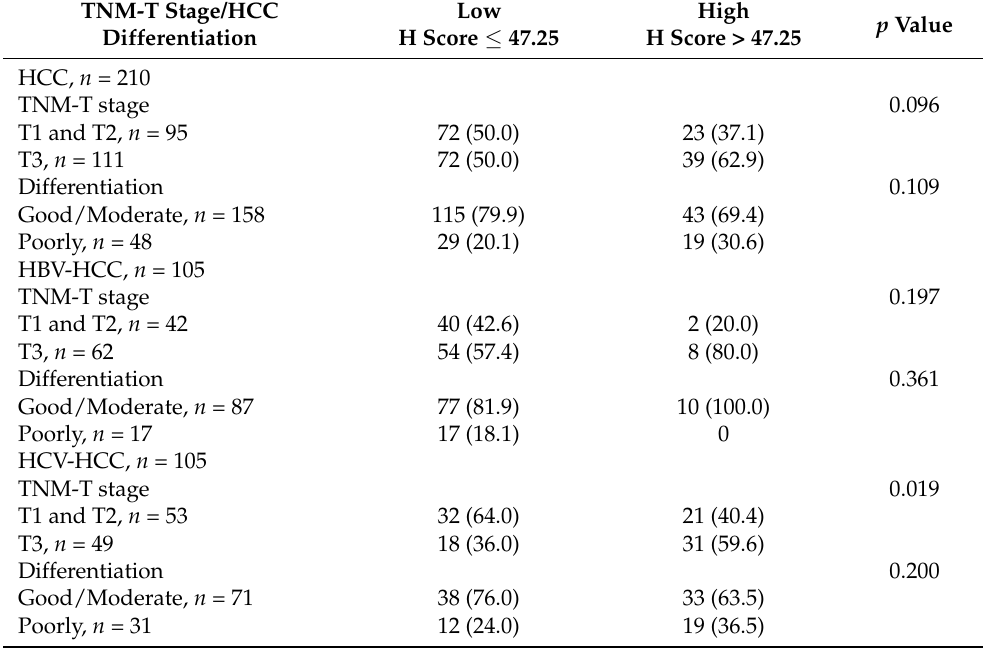
Table 4. Tid1 expression in liver